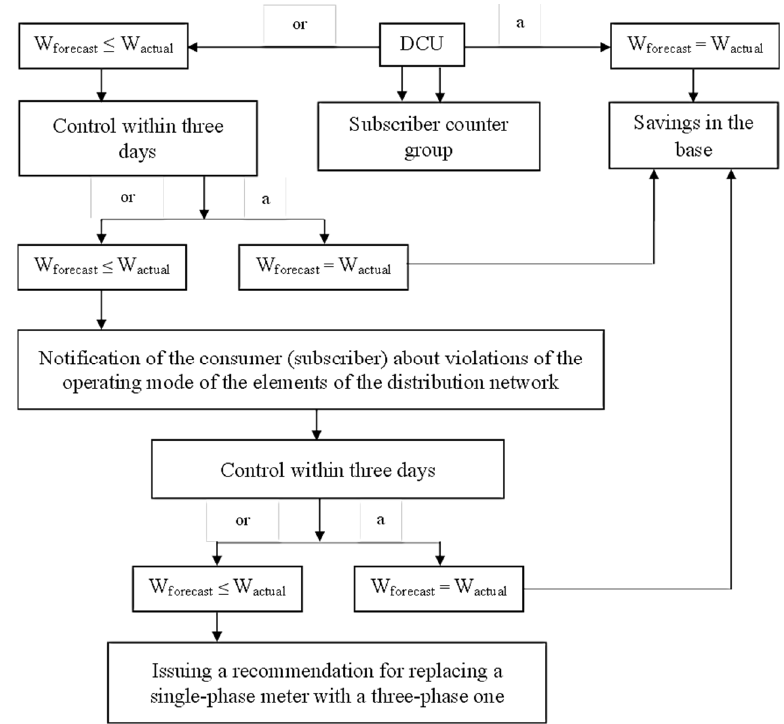
Figure 5. Algorithm for monitoring energy consumption using smart electricity meters.